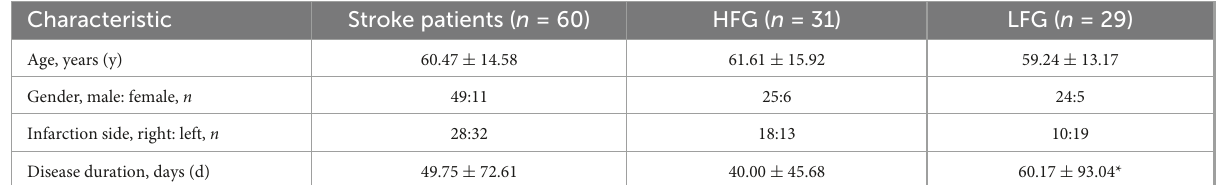
TABLE 1 Characteristics of subjects and